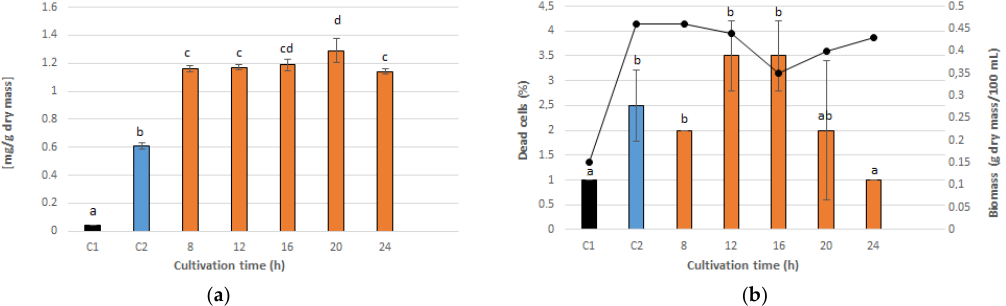
Figure 5. Effect of cultivation time on vitamin C accumulation in yeast cells ( a ). Effect of cultivation time on the number of dead yeast cells and on biomass ( b ). C1—control culture without vitamin C added to the medium and PEF treatment, C2—control culture with vitamin C added to the medium (5 mg/mL medium) and without PEF treatment, orange bars—cultures treated with PEF (vitamin C, 5 mg/mL medium; voltage, 1000 V; pulse width, 10 µs; treatment time, 20 min; number of pulses, 1200). Each value is the mean ± standard deviation ( n = 3). Bars with the same letter (a–d) are not significantly different ( p < 0.05).